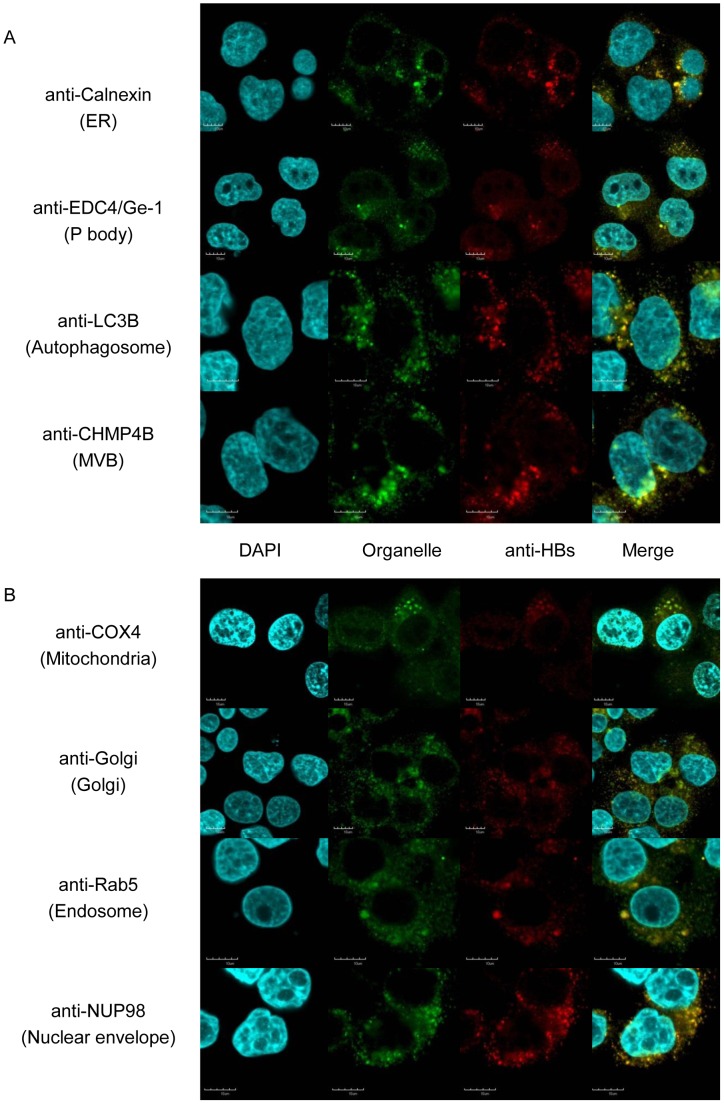
HBsAg localization.A) Co-localization of anti-HBs suggests that HBs localizes in the ER, processing bodies, autophagosomes, and multivesicular bodies, B) and more diffusely in mitochondria, Golgi, endosomes, and at the nuclear envelope.